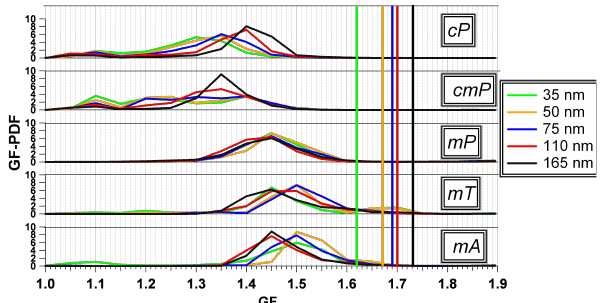
Fig. 13. Hygroscopic growth factors for 35, 50, 75, 110, and 165nm dry particles for cP , cmP , mP , mT and mA air masses. Also shown, in the vertical lines are the growth factors for pure ammonium sul- phate for the corresponding colour coded dry sized particle. Growth Factors in the measurements are limited to a maximum of 2 and therefore do not capture Growth Factors of 2.2 associated with pure